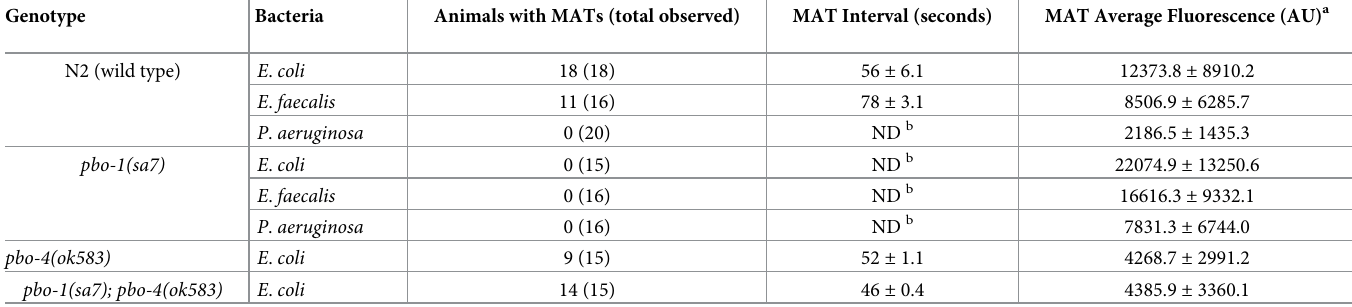
Table 1. MAT analysis using